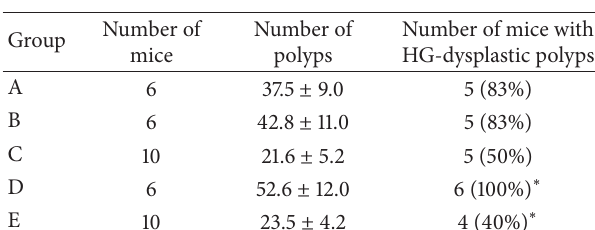
Table 1: Distribution of high-grade (HG) dysplastic polyps among the different groups.